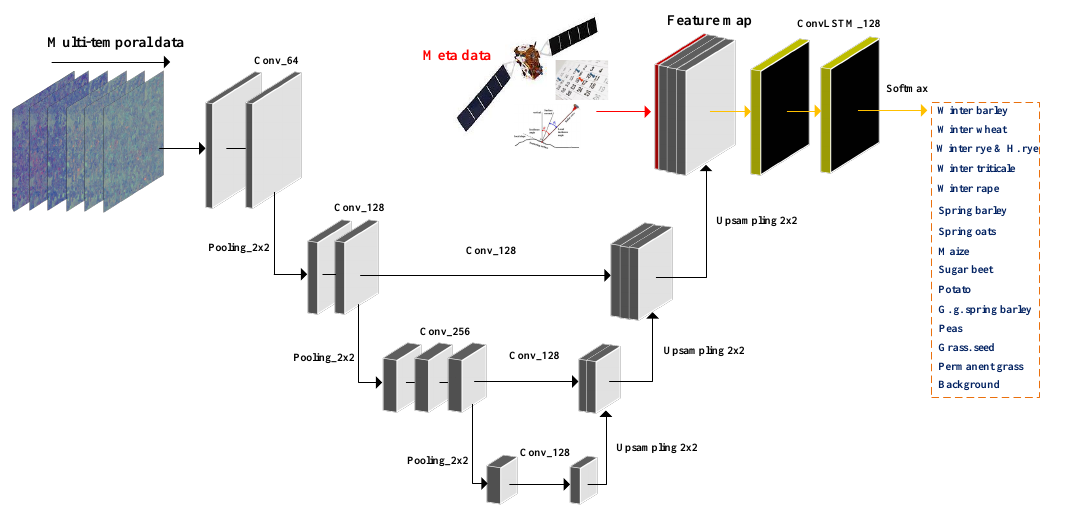
Figure 3. Overall architecture of proposed sequential network for recognizing di ff erent crop